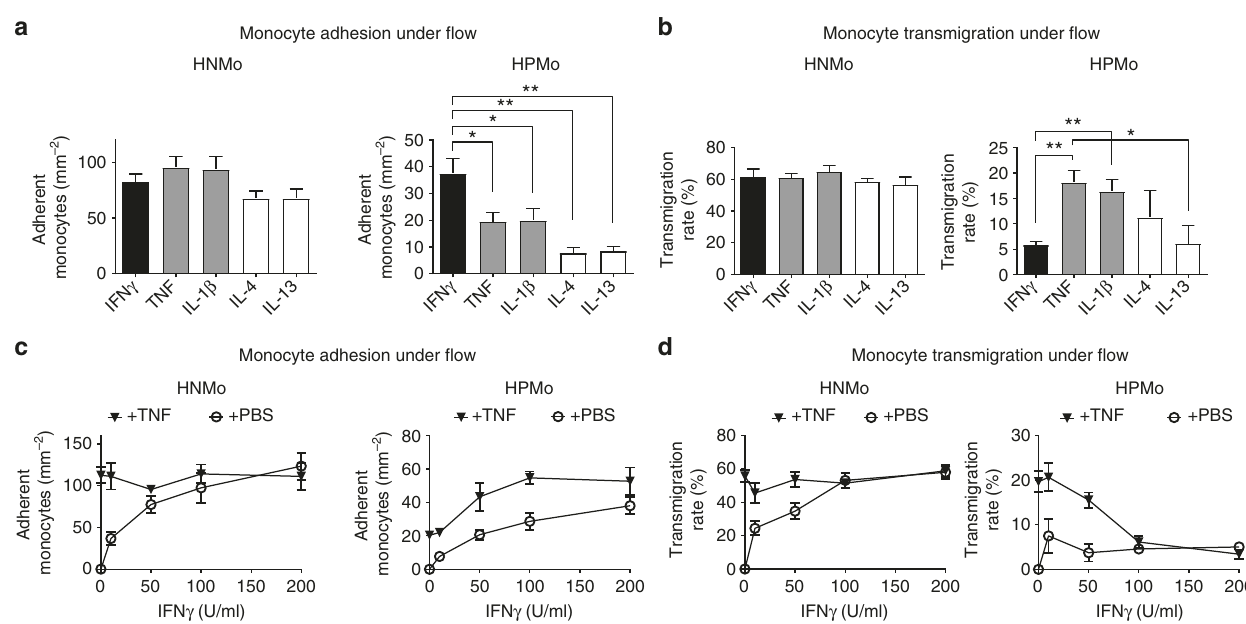
Fig. 4 IFN γ increases proangiogenic monocyte adhesion but abolishes transmigration. a Analysis of proangiogenic versus non-angiogenic monocyte adhesion to endothelial monolayer activated with different in fl ammatory cytokines. n = 4 independent experiments with monocytes from four different donors, cell counted in 1 mm 2 area, the data presented as mean ± s.d., * p -value < 0.05, ** p -value < 0.005 in ANOVA test. Proangiogenic monocytes adhered at higher levels to IFN γ -activated endothelium. b Analysis of proangiogenic versus non-angiogenic monocyte transmigration to the endothelial monolayers activated with indicated in fl ammatory cytokines. n = 4 independent experiments with monocytes from four different donors, 40 individual cells tracked per condition, the data presented as mean ± s.d., * p -value < 0.05, ** p -value < 0.005 in ANOVA test. IFN γ -activated endothelium exhibited the lowest transmigration rate for proangiogenic monocytes. c Analysis of the dose-response effect of IFN γ on monocyte subset adhesion to TNF-activated endothelial monolayer. n = 3 independent experiments with monocytes from three different donors, cell counted in 1 mm 2 area, the data presented as mean ± s.d. IFN γ induced a dose-dependent increase in proangiogenic monocyte adhesion to TNF-activated endothelium. d Effect of IFN γ on monocyte transmigration through TNF-activated endothelial monolayers. n = 3 independent experiments with monocytes from three different donors, the data presented as mean ± s.d. Increasing concentrations of IFN γ induced a dose-dependent inhibition of proangiogenic monocyte transmigration through